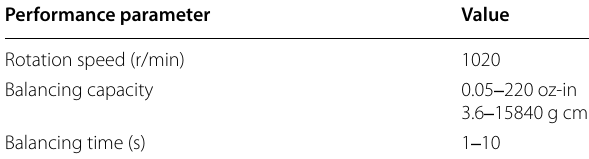
Table 1 Performance parameters of the IPBS